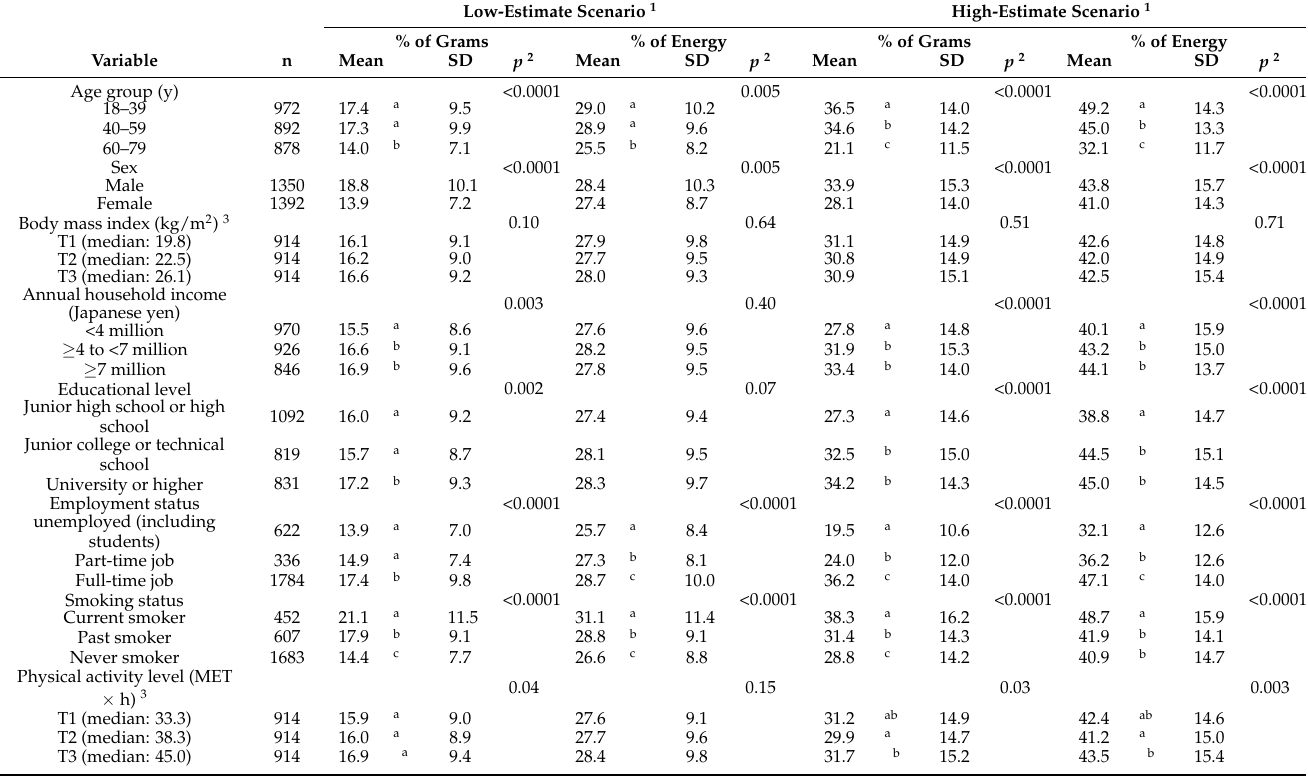
Table 4. Percentage contribution of highly processed foods (in weight and energy) estimated from 8-day dietary records according to categories of basic characteristics among 2742 Japanese adults.